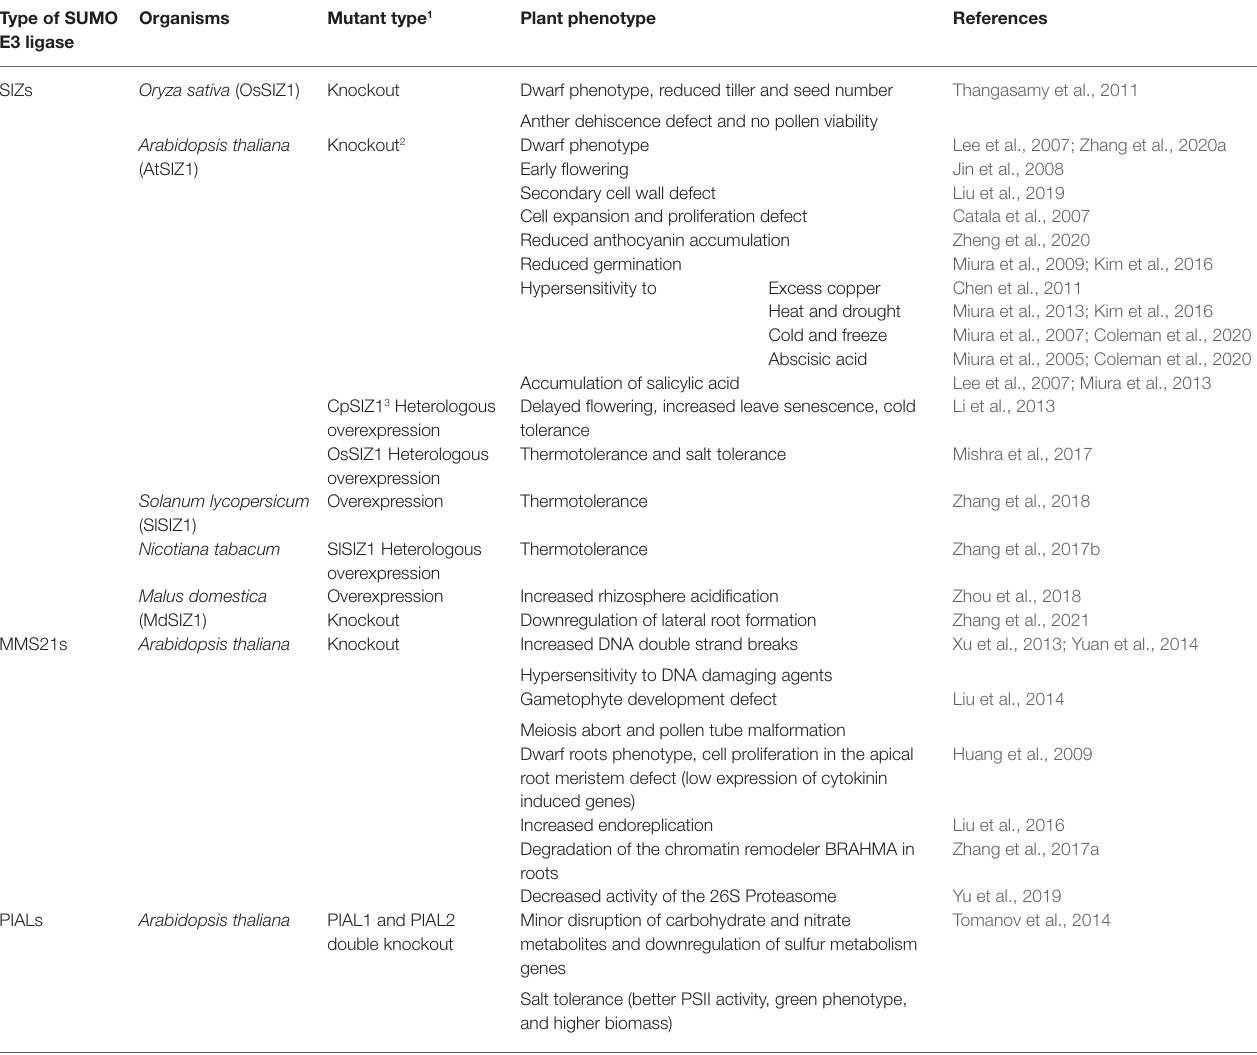
TABLE 1 | Small ubiquitin-like modifier (SUMO) E3 ligase mutants in plants and their